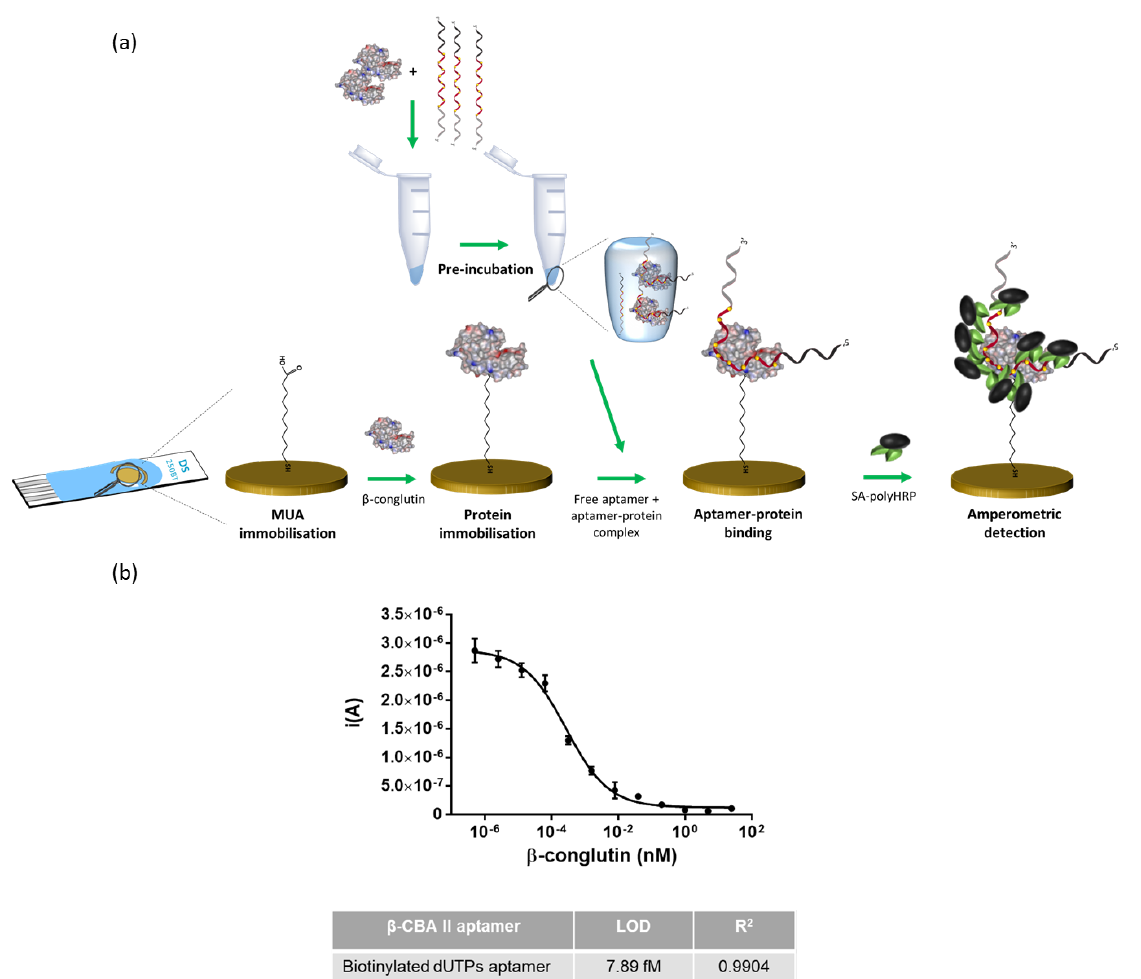
Figure 4. Competition assay on carbon screen-printed electrode: ( a ) schematic representation of the assay and ( b ) calibration curve.